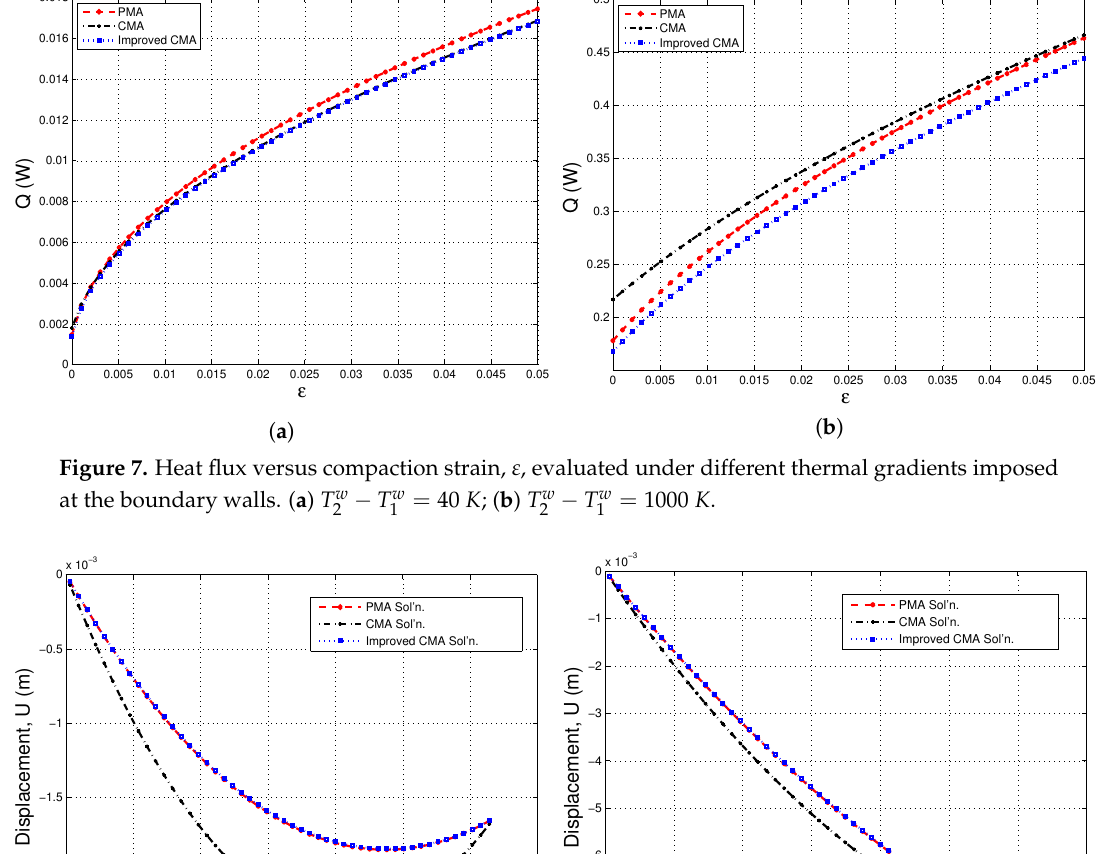
− T w = 1000 K and 2 1